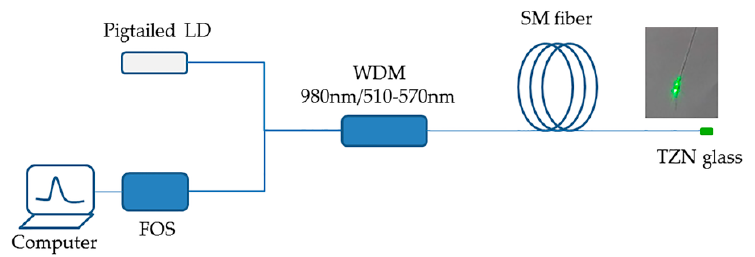
Figure 1. Schematic diagram of experimental arrangement used for optical fiber temperature sensing. The upper right corner presents the strong green upconversion emission at a power of 1 mW.